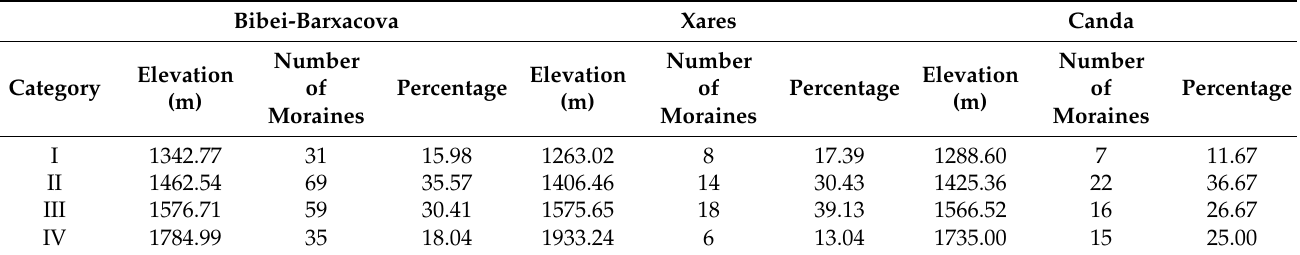
Table 3. Elevational moraine ridge characteristics in each